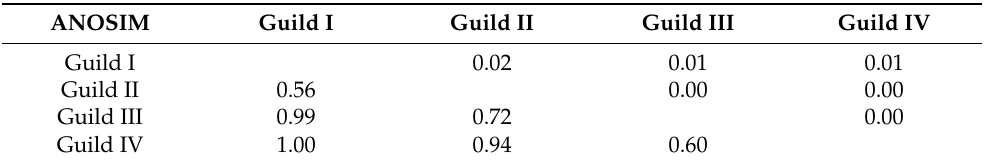
Figure 3. Hierarchical cluster analysis (Bray–Curtis similarity) and non-metric multidimensional scaling (NMDS) ordination based on δ 13 C and δ 15 N signatures for trophic guilds of fish in the midstream of the Chishui River. Guild I represents herbivores; Guild II represents herbivore-based omnivores; Guild III represents carnivore-based omnivores; Guild IV represents carnivores. Table 2. Analysis of similarity (ANOSIM) to each pair of trophic guilds of fish in the midstream of the Chishui